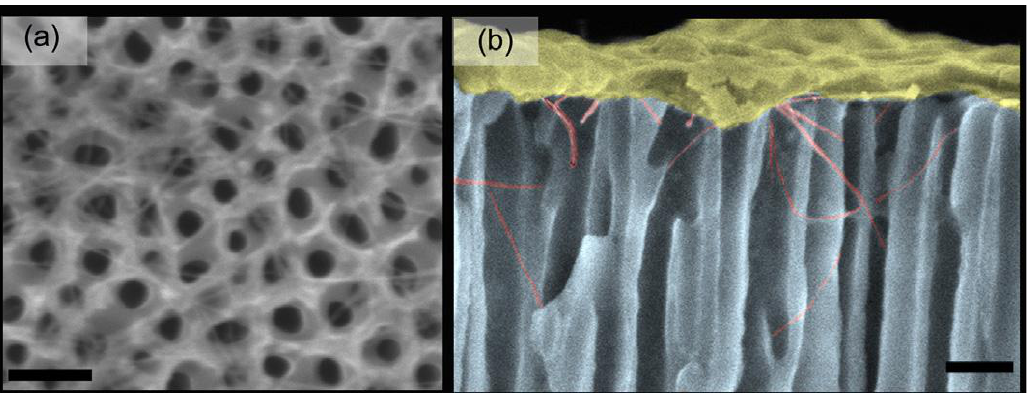
Figure 10. SEM micrographs of assembled SWCNT in anodic alumina array: ( a ) top view and ( b ) cross-sectional view. The top layer at this colored picture is the sputtered Au for imaging purposes. The scale bars are 120 nm. Reproduced from